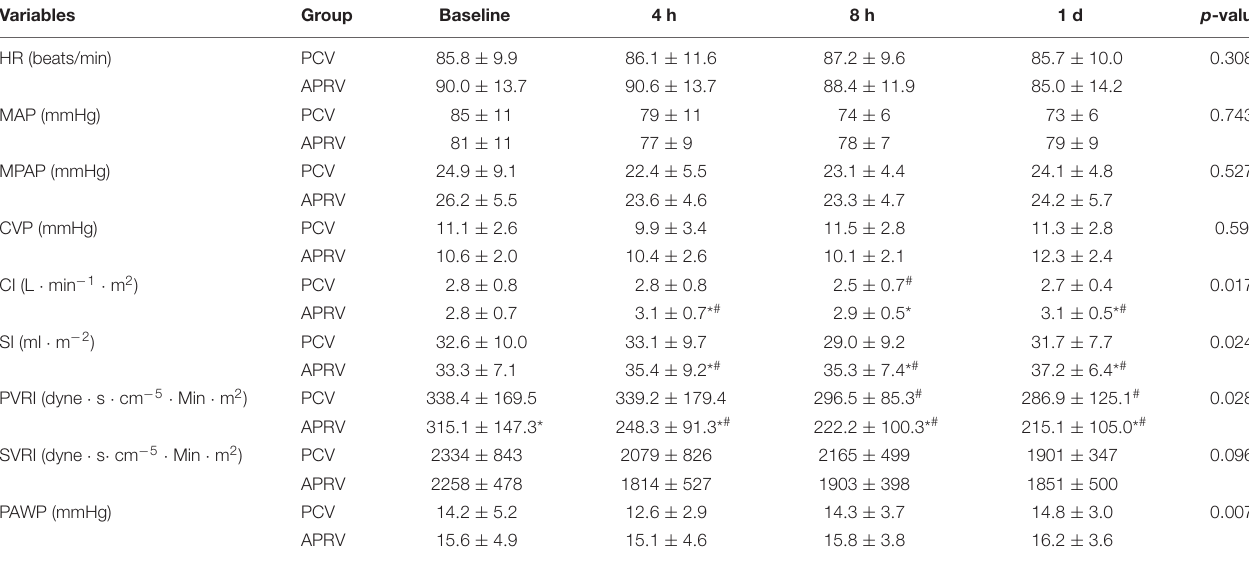
TABLE 2 | Hemodynamics parameters. Variables